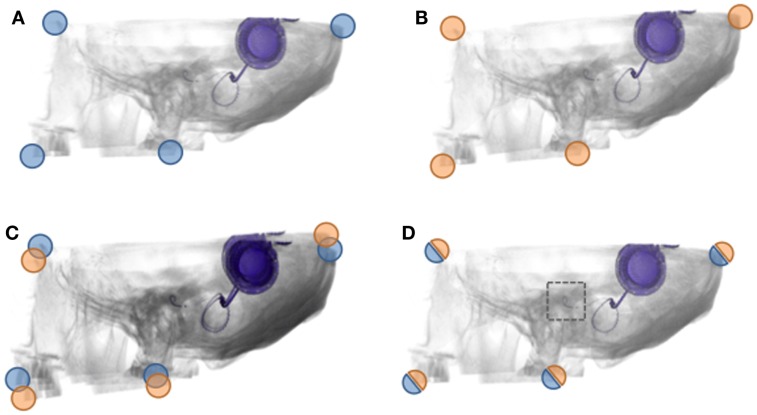
Image fusion: registration and superimposition of CBCTs. (A,B) An illustration of the first (A) and second CBCT (B). The corner markings aim to represent the concept of fiducials (respectively, blue and orange). (C) An illustration of how CBCTs volumes fused without registration would look superimposed. Notice the discernible overlap, both in the image as the corner fiducials. (D) An illustration of how CBCTs volumes fused with registration would look superimposed. No discernible overlap is present, and the area of interest (dotted box) can be visually assessed. The fiducials are aligned as well.